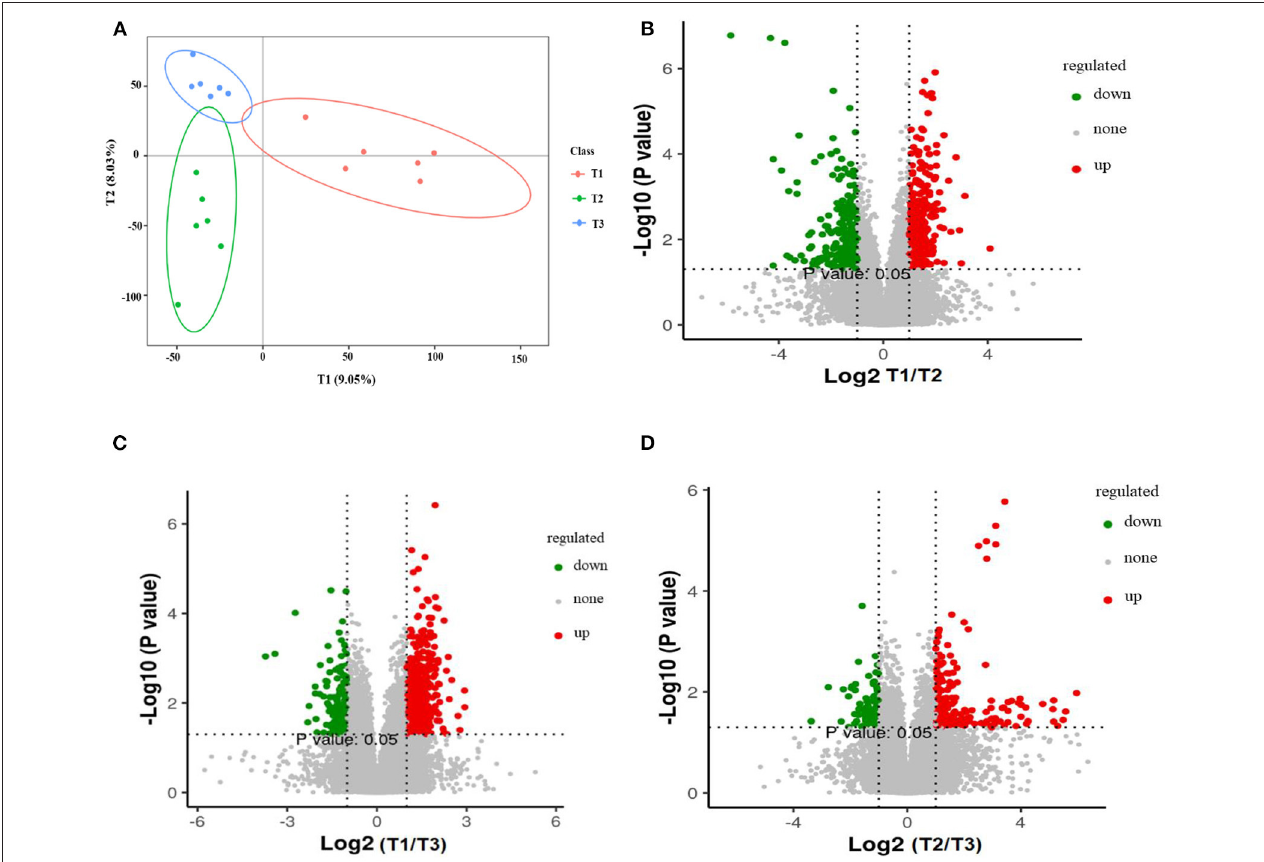
FIGURE 8 | Partial least squares discriminant analysis (PLS-DA). The PLS-DA of microbial metabolites in cecal tissue of goats (A) . Volcano plot showing the differential metabolites (red dot: significantly up-produced metabolites, green dot: significantly down-produced metabolites, gray dot: the metabolites with no significant difference, Q < 0.05) (B–D) . T1 (normal corn 100%, high amylose corn 0%); T2 (normal corn 50%, high amylose corn 50%); T3 (normal corn 0%, high amylose corn